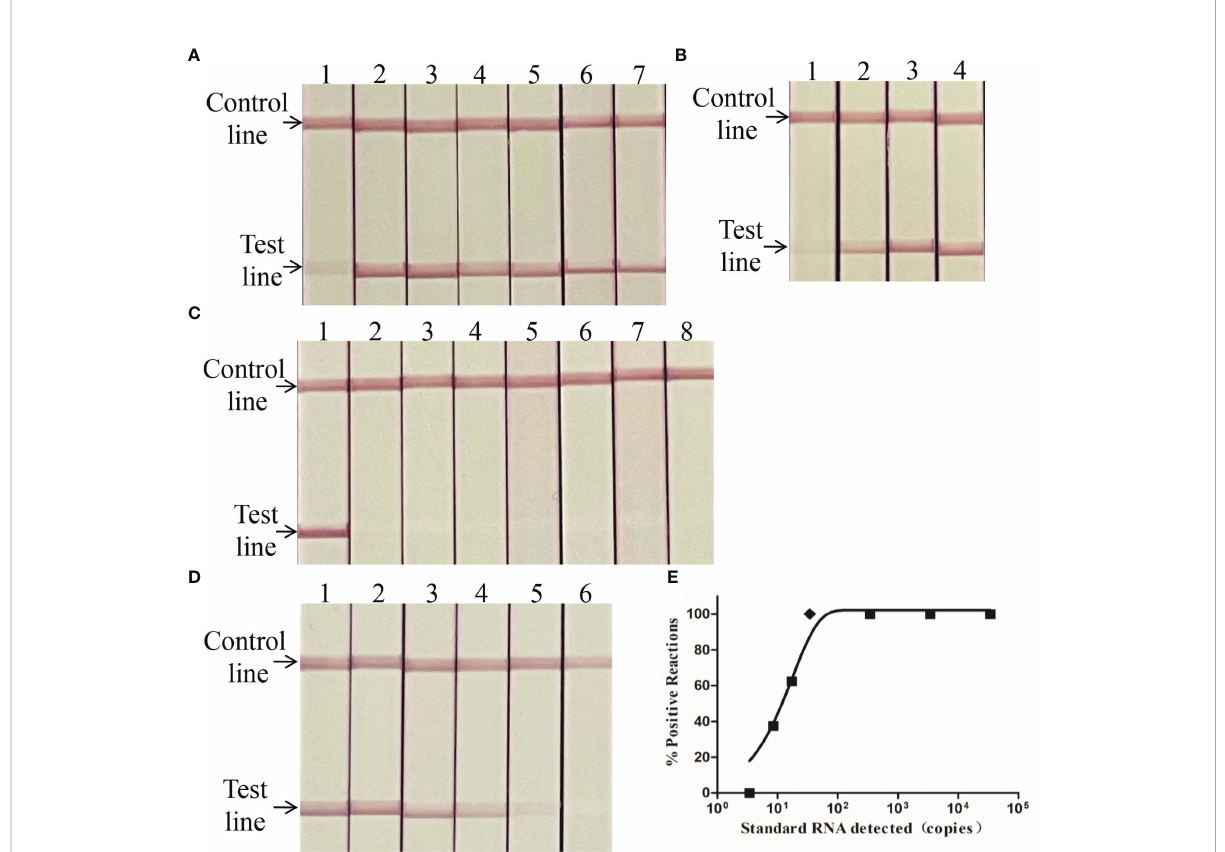
FIGURE 2 Performance of the HEV LFB RT-RPA assay. (A) Optimization of the lateral fl ow biosensor (LFB) RT-RPA reaction temperature. Lanes 1 – 7: 39, 40, 41, 42, 43, 44, and 45°C. (B) Optimization of the LFB RT-RPA incubation time. Lanes 1 – 4: 5, 10, 20, and 30 min. (C) Evaluation of the analytical speci fi city of the LFB RT-RPA assay. Lanes 1 – 8: HEV, PRRSV, CSFV, FMDV, PRV, PCV2, PPV, and ddH 2 O. (D) Evaluation of the analytical speci fi city of the LFB RT-RPA assay. Lanes 1 – 6: 3.4 × 10 5 – 3.4 × 10 0 copies/ m l. (E) Probit regression analysis of the LFB RT-RPA assay using the data of the positive samples from each of the eight replicates. The limit of detection at 95% probability (24 copies/ m l) is depicted by a